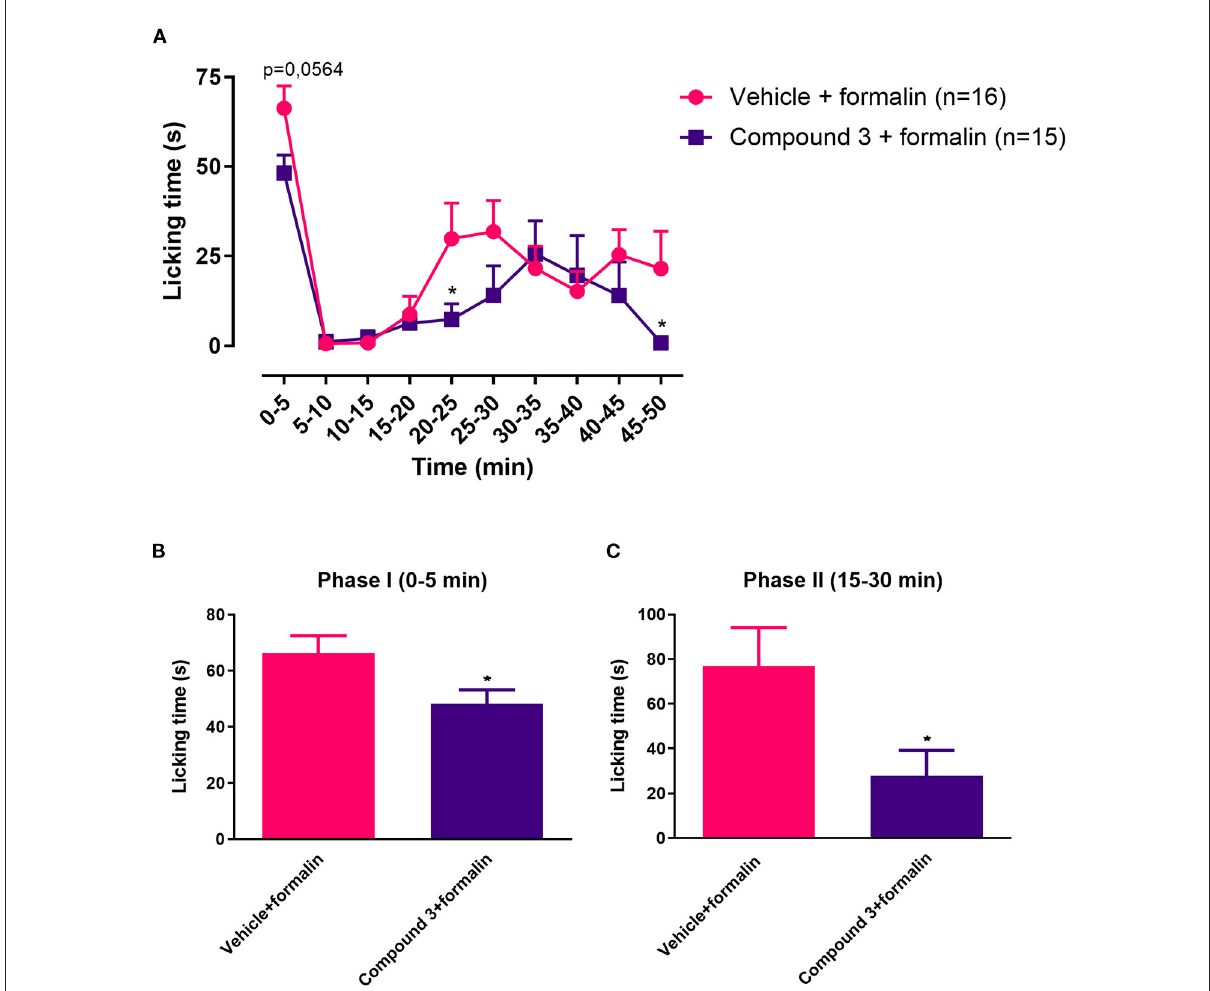
FIGURE3 Time course (A) and cumulative licking time (B,C) induced by formalin injected in the hindpaw, after pre-treatment with a single dose of vehicle or cpd3 (110 mg/kg). (A) Multiple unpaired T -test of Two-way ANOVA. (B,C) T -test, * p < 0.05 compared to vehicle + formalin group.